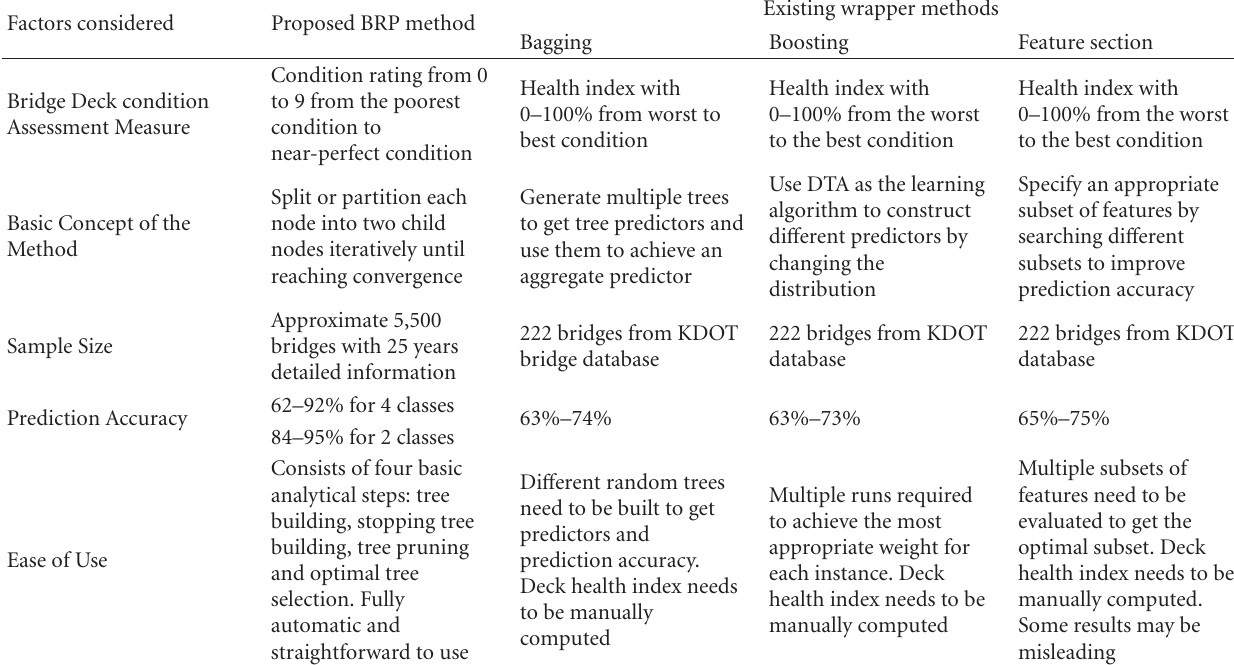
Table 7: Comparison of proposed BRP method with three existing wrapper